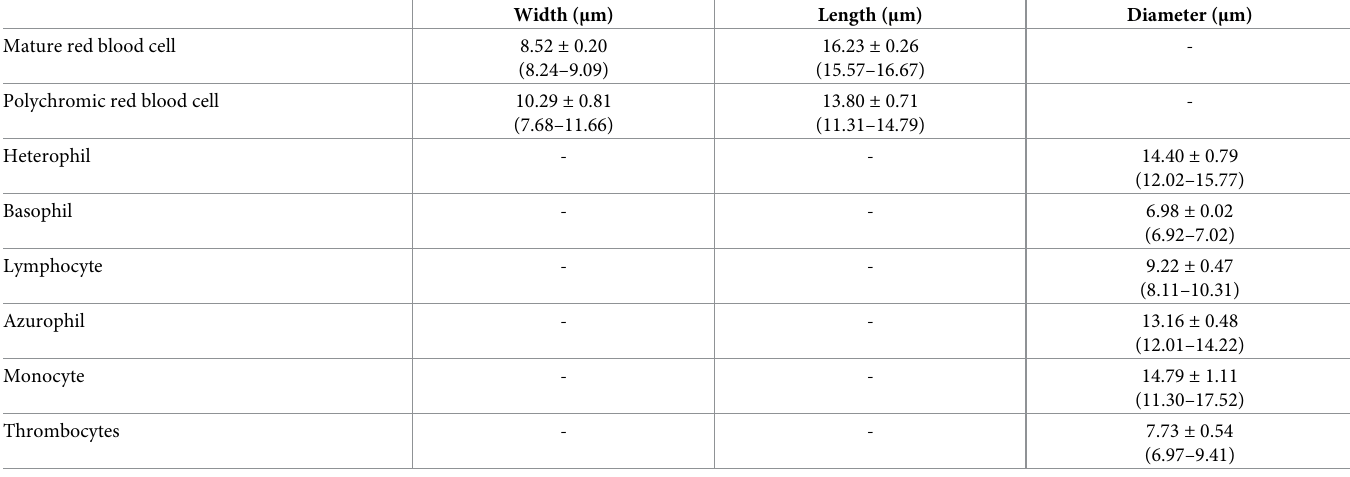
Table 6. The sizes of peripheral blood cells of Asian water monitors (median ± SE and 95% confidence